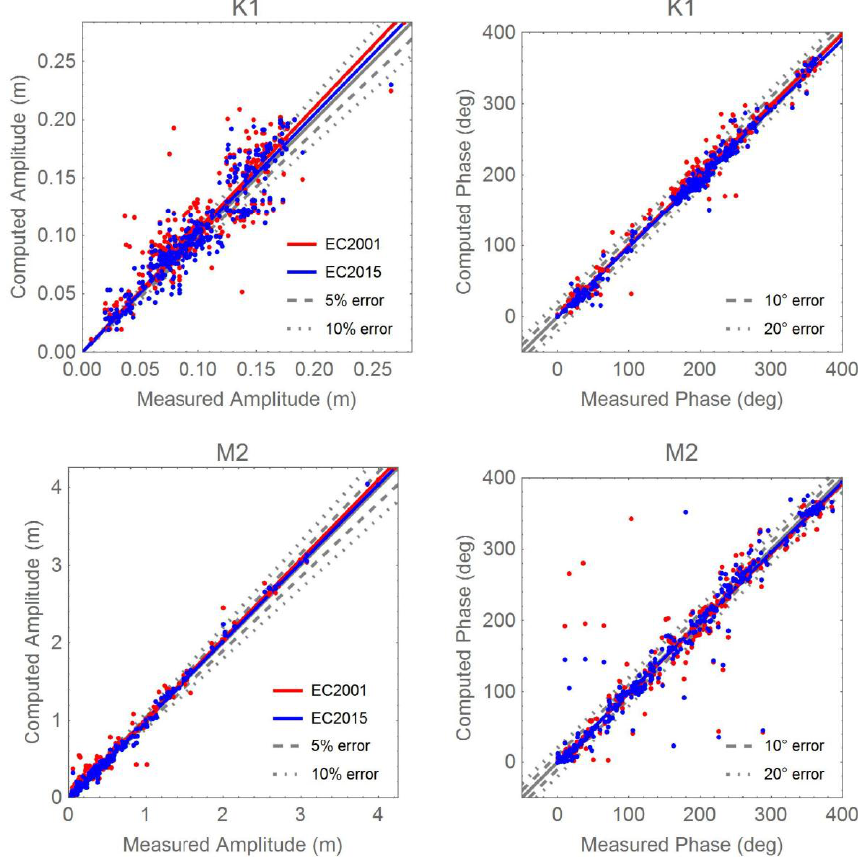
Figure 8. Comparison of scatter plots for the dominant constituents (K 1 , M 2 ) for the EC2001 and EC2015 tidal databases using the 367 common validation data stations.